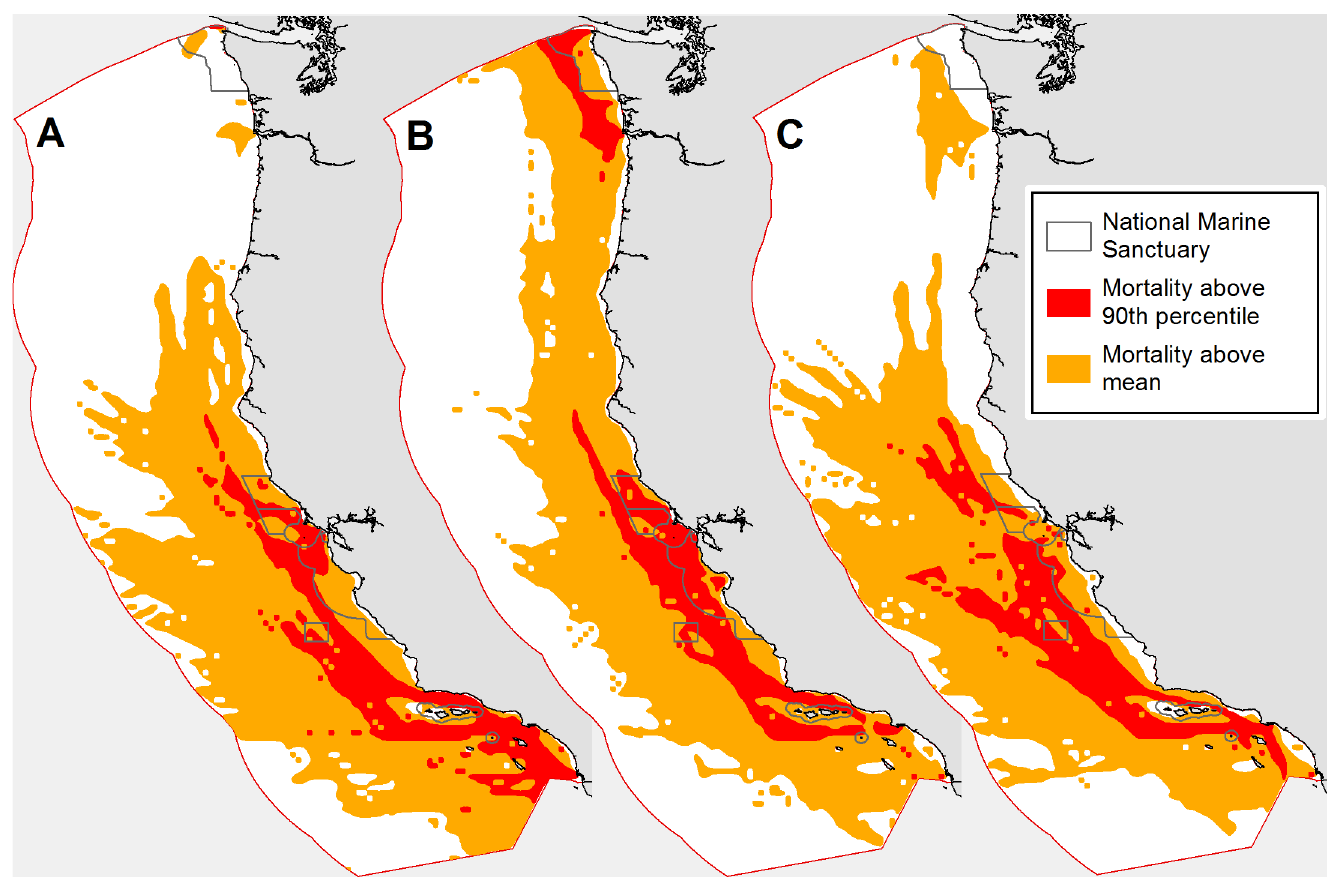
Fig 4. Areas classified as above the study area mean (orange) and greater than the study area 90 th percentile (red). Panels depict whalemortality for blue (A), humpback(B), and fin (C). Dashedlines represent the NationalMarine Sanctuaries.